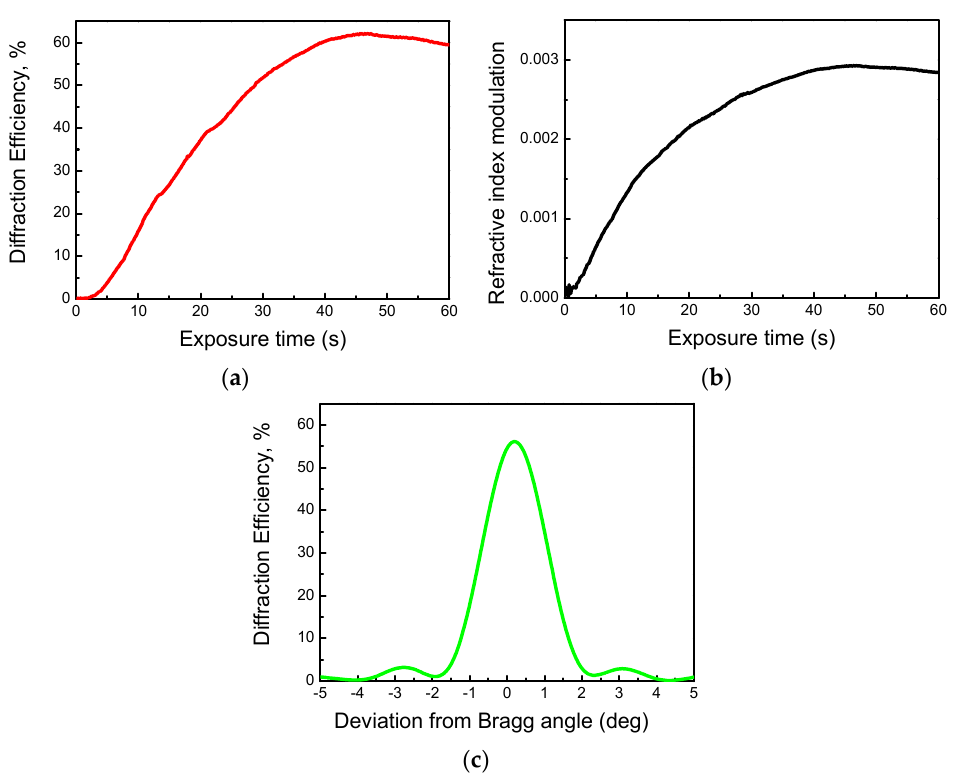
Figure 8. Example curves obtained during and after recording in layers of 70 μ m thickness prepared from composition C. ( a ) Real time diffraction efficiency; ( b ) refractive index modulation; ( c ) Bragg selectivity curve.